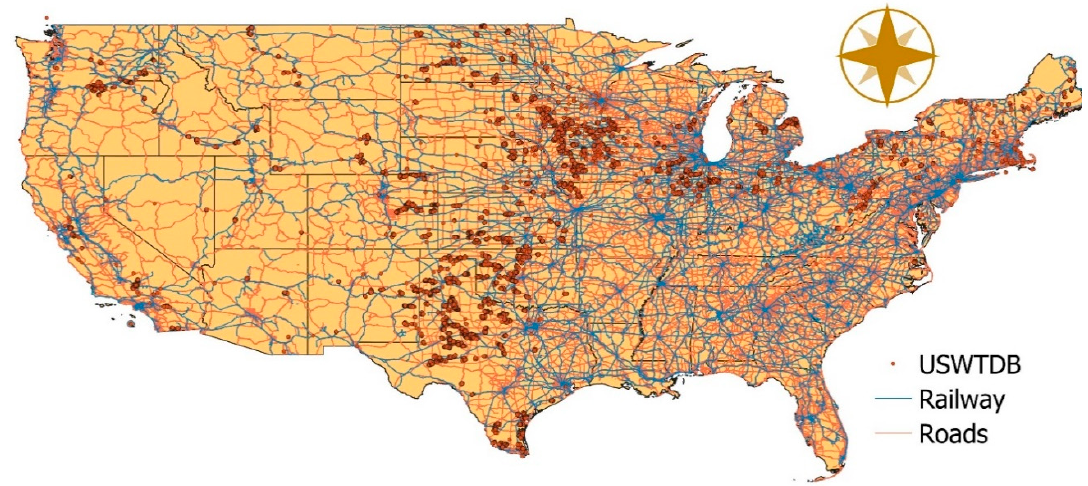
Figure 3. US—GoWInD displaying some of its integrated databases. USWTDB [20] and roads [48,49] are updated to 2020 and railways to 2018 [50].